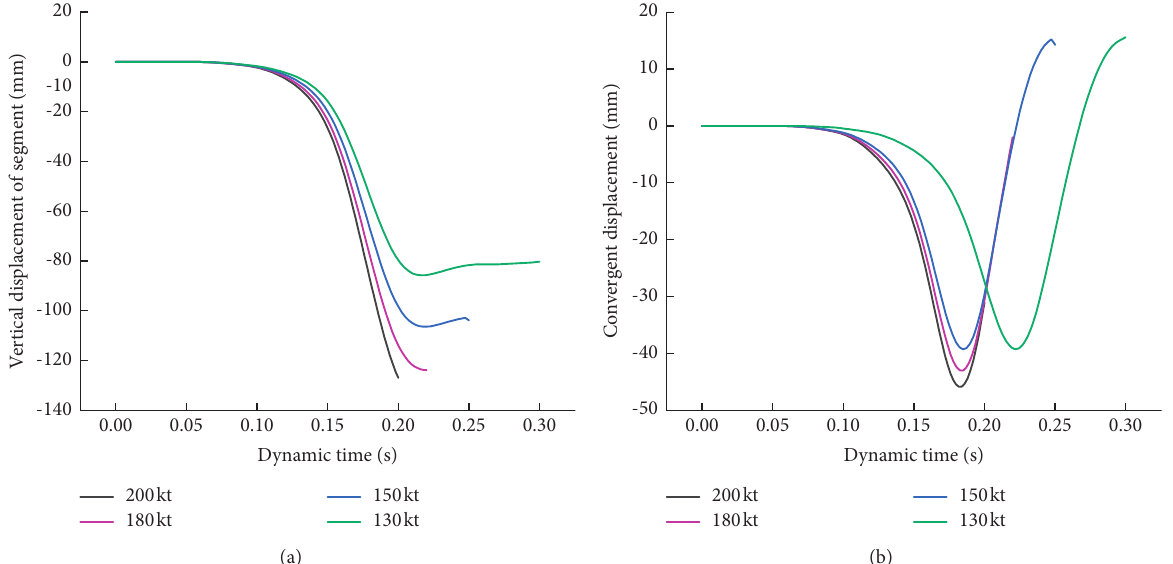
Figure 10: Time-history curves of deformation response of tunnel segments under different sliding speeds. (a) Vertical displacement of a segment. (b) Convergent displacement of a segment.